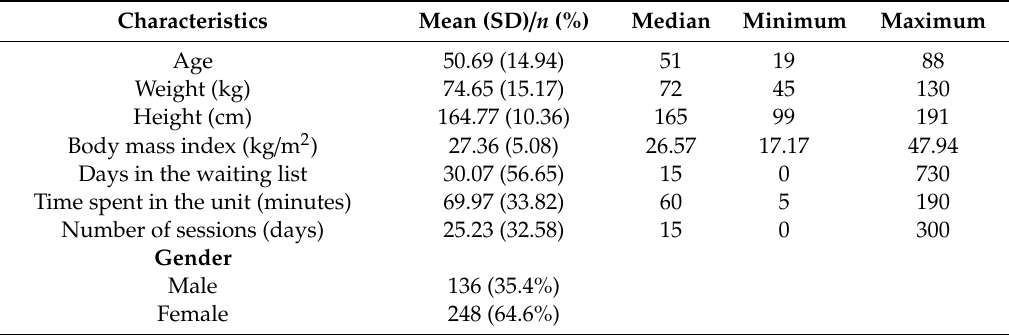
Table 1. Demographic, anthropometric and clinical characteristics of the